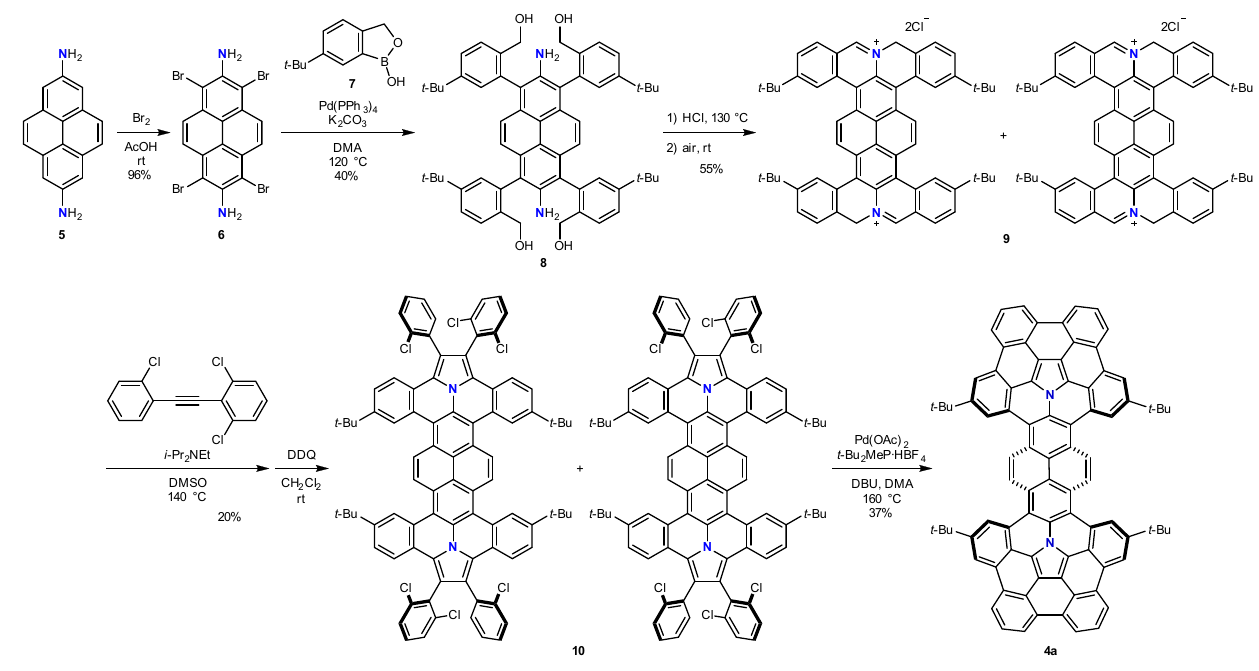
Fig. 2 Synthetic route to azacorannulene dimer 4a